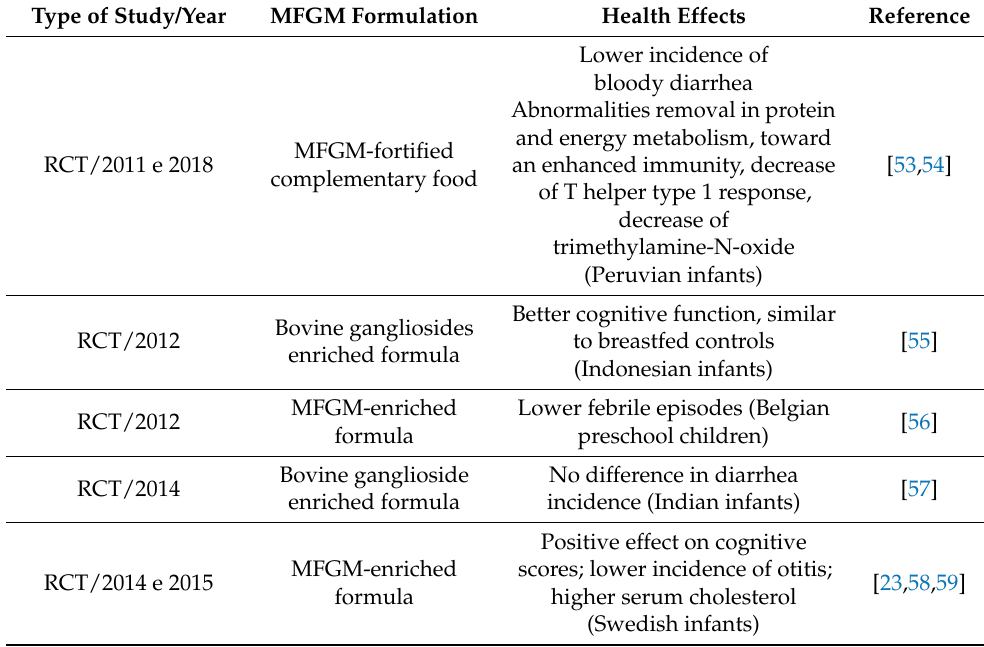
Table 1. Studies with bovine MFGM-enriched formula or lipids as dietary